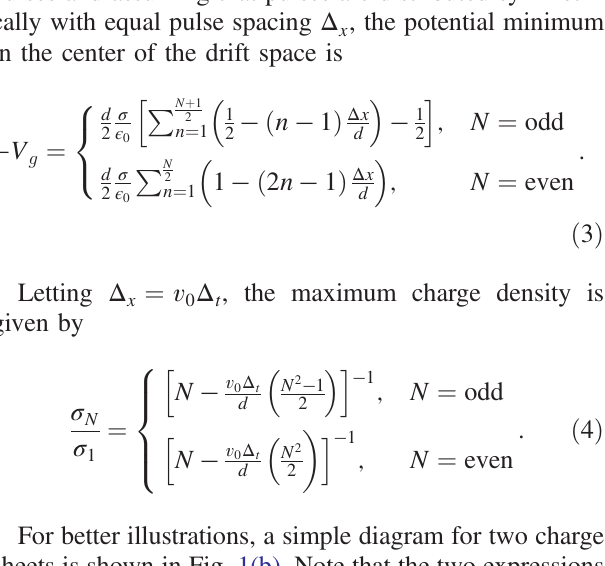
FIG. 1. A drift space with gap spacing d with (a) single pulse injection and (b) two pulse injections,